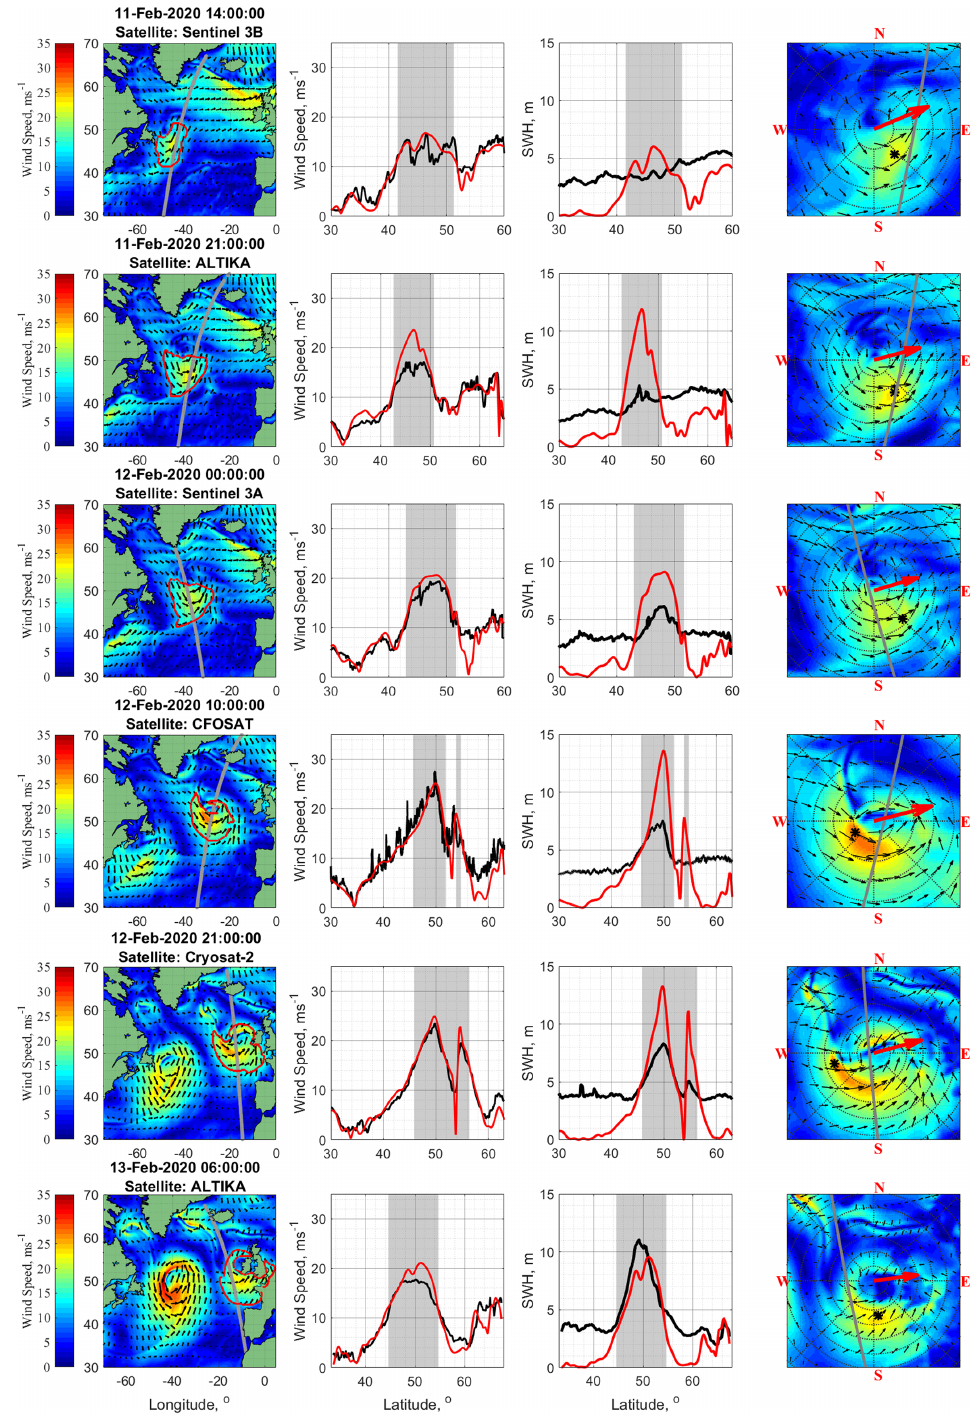
Figure 5. Wind speed and SWH along the AltiKa, CryoSat-2, Sentinel-3, and CFOSAT-SWIM nadir tracks at the different moments of ETC#1 lifetime. Columns from left to right, (1st column): NCEP/CFSv2 wind field and position of the track; (2nd column): along-track wind speed from (black line) measurements and (red lines) NCEP/CFSv2; (3rd column): profile of measured SWH (black line) and SWH of fully-developed waves for local wind speed (red line); (4th column): zoom on the ETC#1 storm (inner) area (shown in the first column by red contour). The red arrows in the fourth column indicate the ETC’s direction, and the radius of dashed circles changes from 200 km at a 200 km interval. Vertical shaded areas in columns 2 and 3 indicate the parts of the tracks that fell into the ETC’s storm area, shown in the first column by red contour. The position of u m is indicated by a black